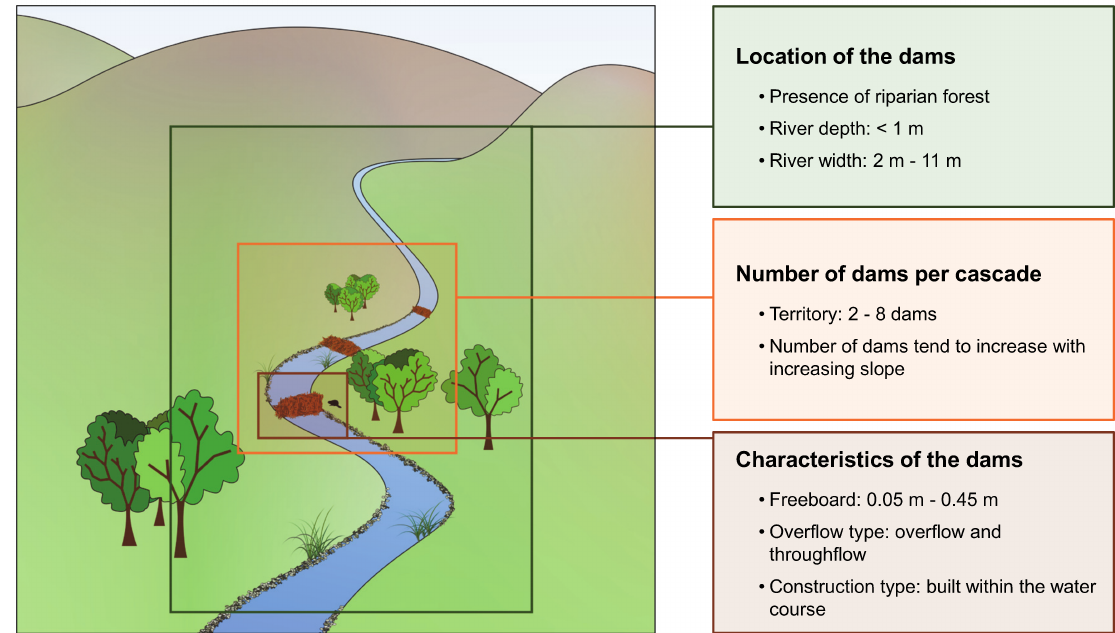
Figure 6. Three-stage scheme for creating realistic beaver dam scenarios in the hydraulic models. Table 3. Characteristics of the developed dam cascades C 1 and C 2 at the Otterbach and the Glonn. Investigation